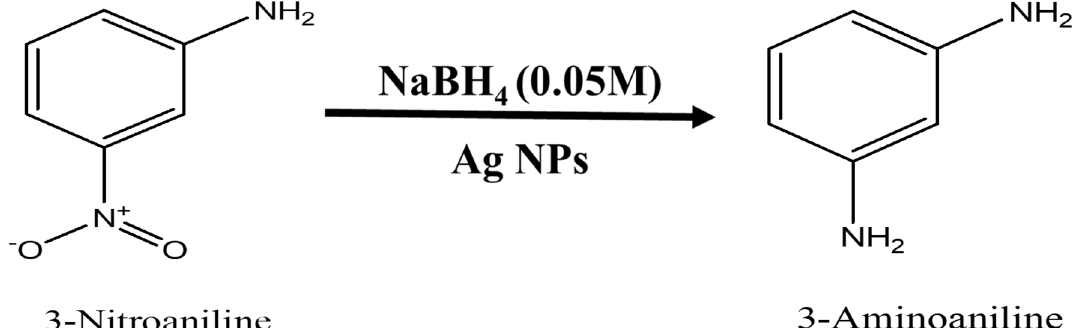
Figure 17. Schematic chemical reaction of conversion of 3-nitroaniline to 3-aminoaniline.